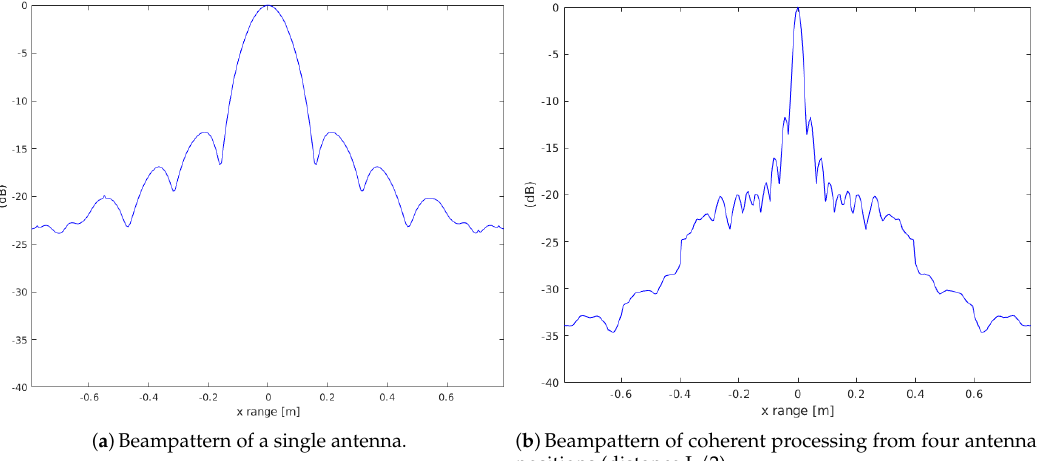
Figure 3. The synthetic aperture sonar (SAS) beam pattern from four adjacent positions and signal parameters f s = 200 kHz, f 0 = 400 kHz and pulse length T p = 1 a significant gain in